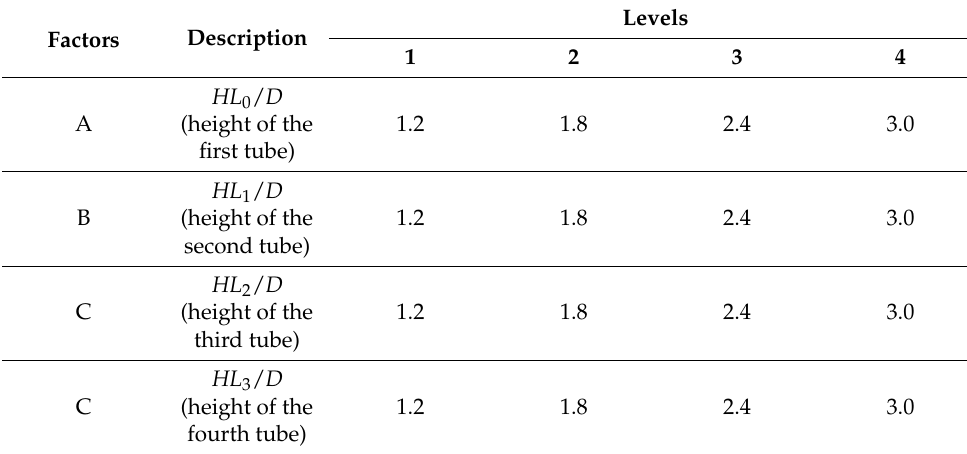
Table 2. The range and levels of control parameters.